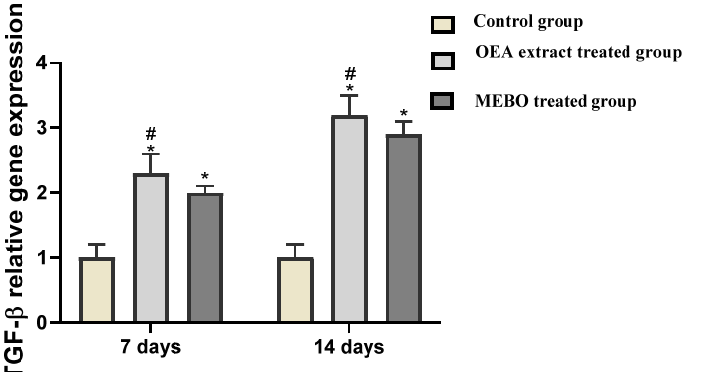
Figure 9. Gene expression in diverse categories of wounded tissues. qRT–PCR was used to examine gene expression in wound tissues. After being adjusted for GAPDH, the results displayed as fold change relative to the control group. The bars represent the mean ± SD. To determine whether there was a substantial difference between studied groups, a two-way ANOVA was performed, with * p < 0.05 comparing to the control group on a particular day and # p < 0.05 comparing to the MEBO ® group on the same day.